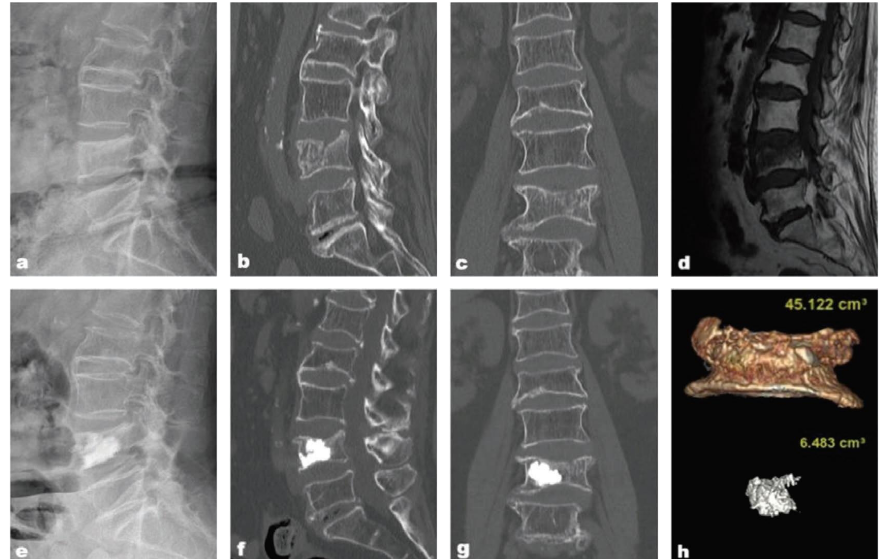
Figure 2: An 80-year-old female patient is diagnosed with an L4 osteoporotic vertebral compression fracture (OVCF). (a) Preoperative lateral X-ray. (b) Preoperative sagittal CT. (c) Preoperative coronal CT. (d) Preoperative MRI. (e) Postoperative lateral X-ray. (f) Postoperative sagittal CT. (g) Postoperative coronal CT. (h) 3D image of the vertebral body and bone